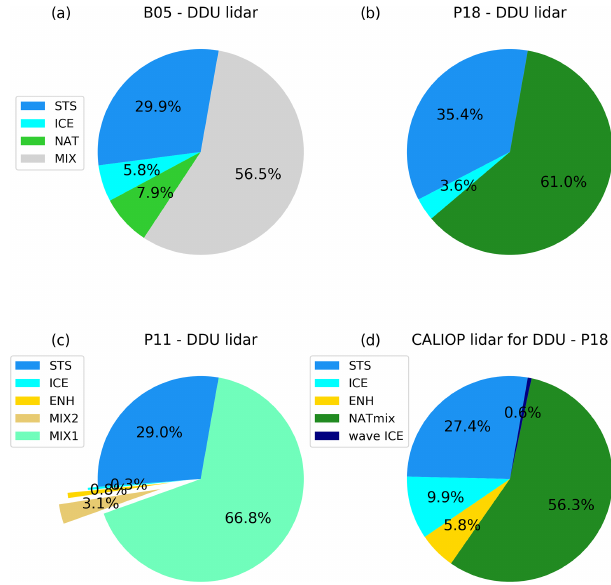
Figure 3. PSC types distribution observed at DDU for the three considered classifications: B05 (a) , P18 (b) , P11 (c) and observed by CALIOP extracted around DDU using P18 scheme (d)